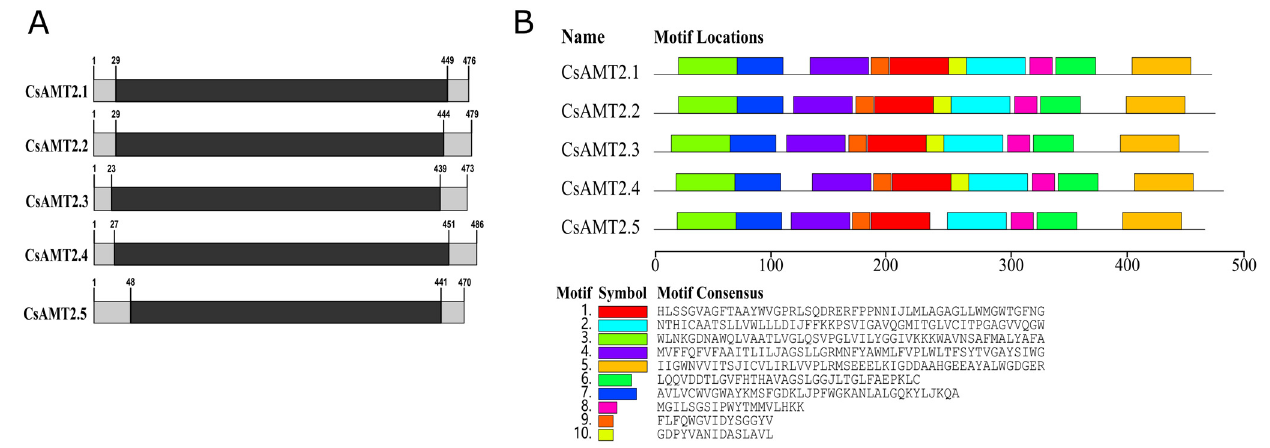
Figure 1. Predicted distribution of conserved domains and motifs of CsAMT2 proteins. ( A ). Ammo- nium_transp (PF00909) protein domains were identified by CDD database; the black boxes indicate the distribution of this conserved domain. ( B ) Positions of ten conserved motifs were identified using MEME; the different boxes and colors identify the putative motifs.